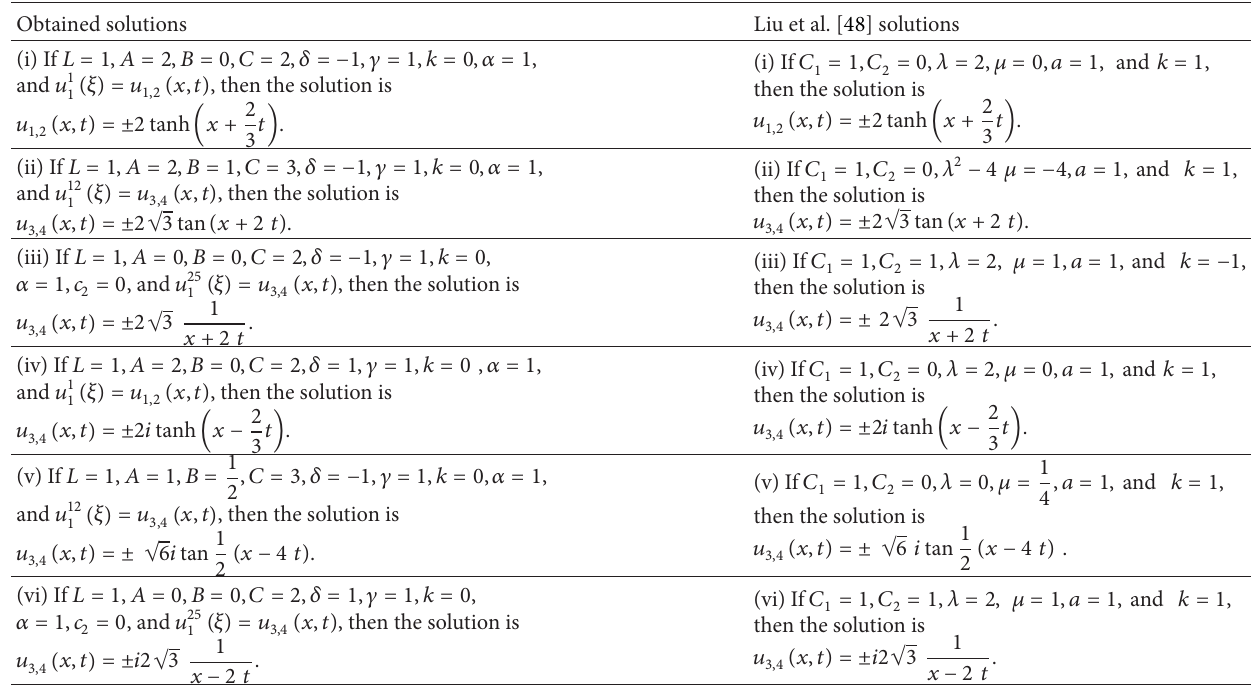
Table 1: Comparison between our solutions and Liu et al. [48] solutions. Obtained solutions Liu et al. [48]